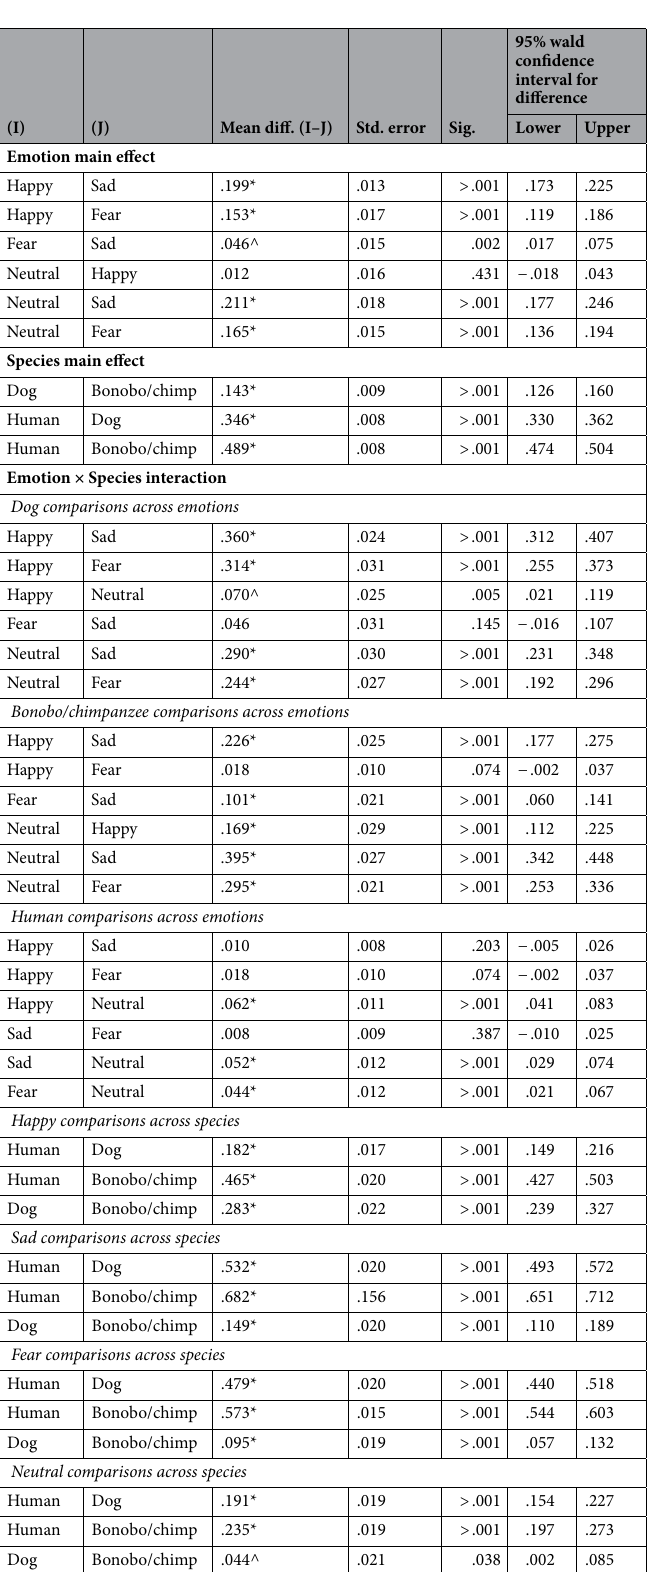
Table 1. Main effects and interaction on accuracy of emotion inferences across species and emotions in Study 1. *significant at Bonferroni corrected p < .0013; (^) marginally